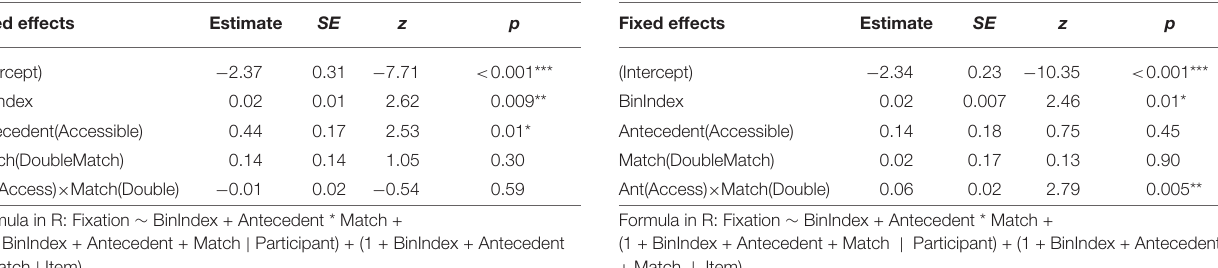
TABLE 3 | Fixed effects from best fitting mixed-effects logistic regression model fit to data for pronouns, Experiment 2. Fixed